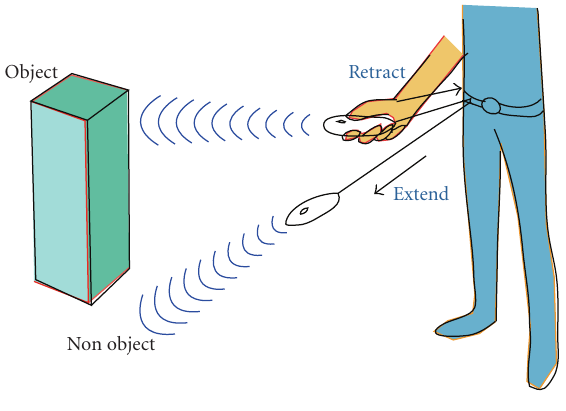
Figure 2: Concept of